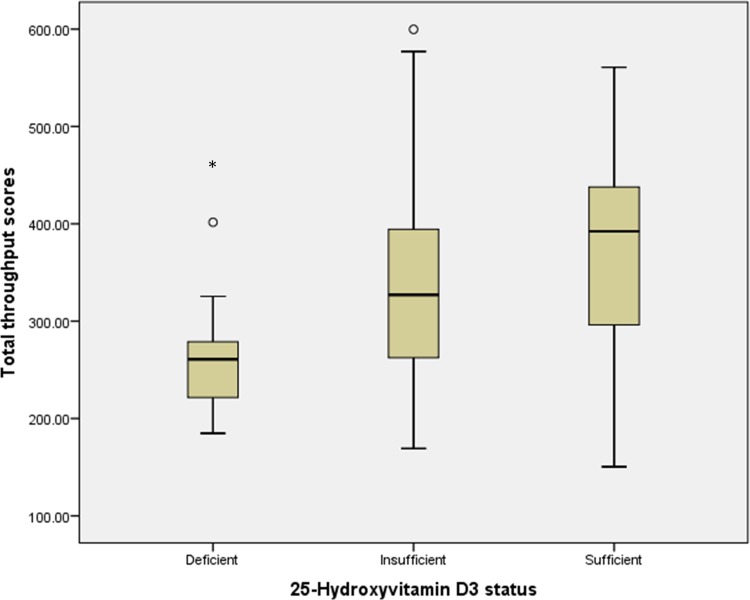
Total throughput scores in relation to 25(OH)D3 status in SLE patients.Box represents 25th and 75th percentiles, horizontal line represents the median, error bars show the 5th and 95th percentile and outside values are shown as dots. F(2,52) = 3.73, p = 0.031.